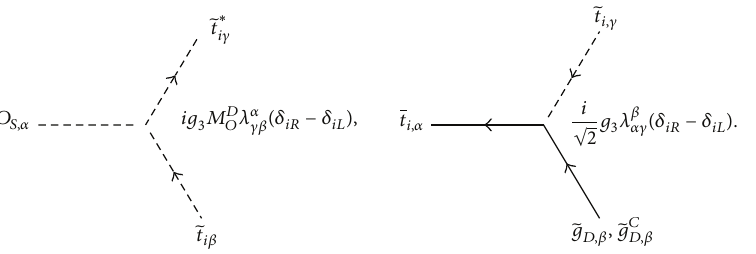
Figure 3: Feynman rules needed to evaluate diagrams of Figure 4. In the right diagram, the charge-conjugated gluino ̃𝑔 𝐶 𝐷,𝛽 applies in the case of 𝑖 = 𝐿 , ̃𝑔 𝐷,𝛽 in the case of 𝑖 = 𝑅 .